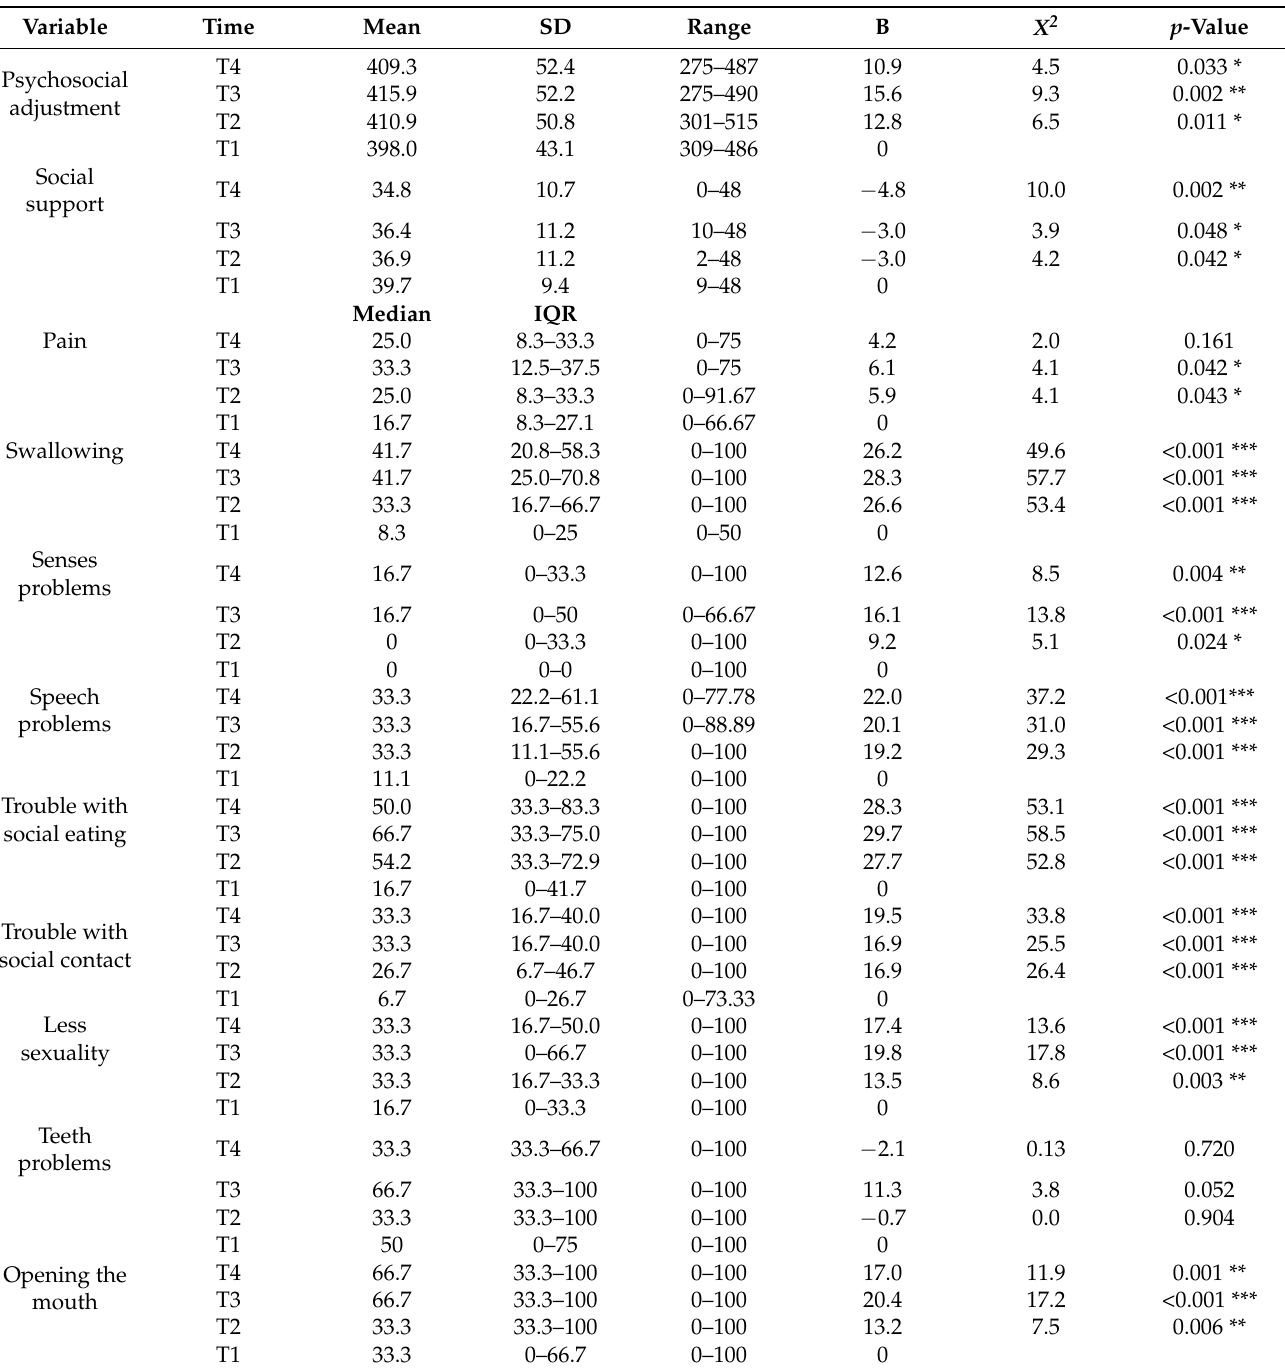
Table 2. Psychosocial adjustment, social support, and symptoms at pre-operation, and one month, three months, and five months after discharge ( n =